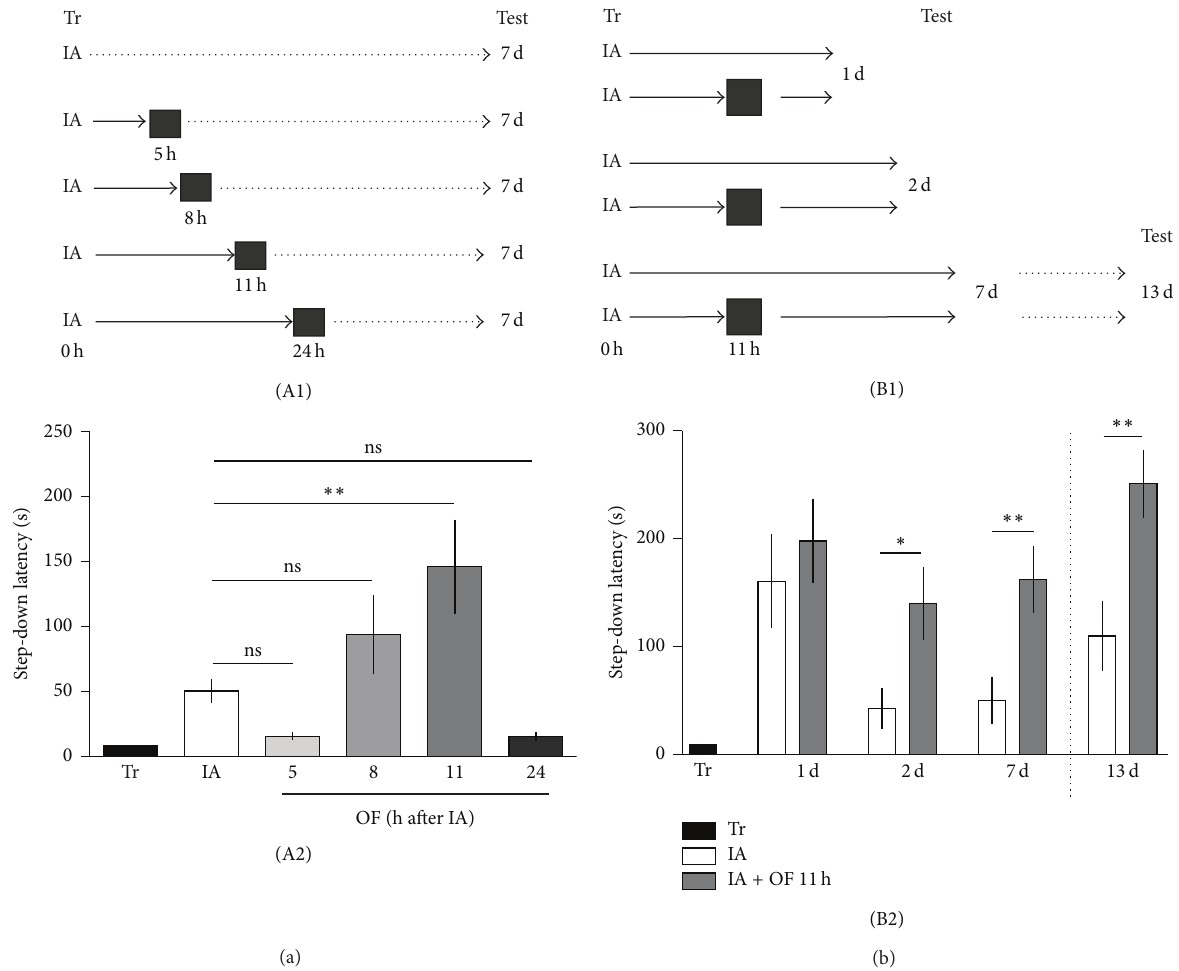
Figure 1: (a) The promoting effect of OF is time-dependent. (A1, B1) Schematic representation of the experimental protocol is presented on the top of each panel. (A2) Animals were trained in the IA and exposed to an OF 5 h, 8 h, 11h, or 24h after a weak IA training. Test was performed 7 days after training. Only the exposure to an OF 11h after training promotes the durability of IA memory. Data are presented as mean ± SEM. (b) Exploration of an open field 11h after training promotes the persistence of weak IA memory. (B2) Animals were trained in the IA and exposed to an OF 11h later. Test was performed in independent groups of animals at 1 day, 2 days, and 7 days after training. A retest was performed at 13 days only with the animals that had been tested at 7 days (note a small increase of latency in this control group probably due to the retest effect). Data are presented as mean ± SEM.